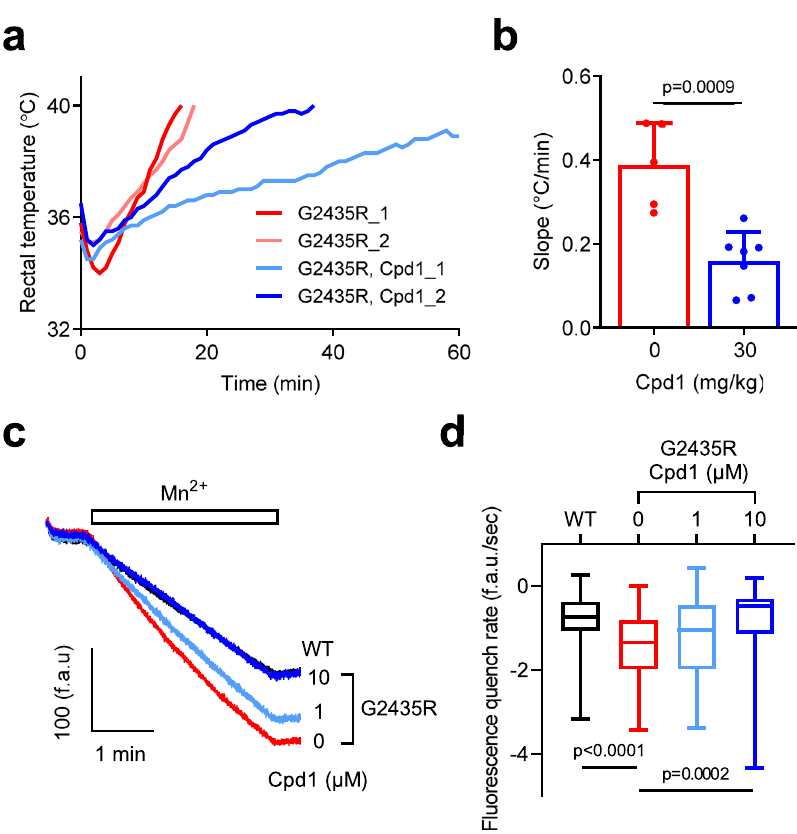
Fig. 8 Effect of Cpd1 on homozygous RYR1-p.G2435R (G2435R) mice. a – b In vivo heat challenge of G2435R mice. Mice were placed in a 38 °C